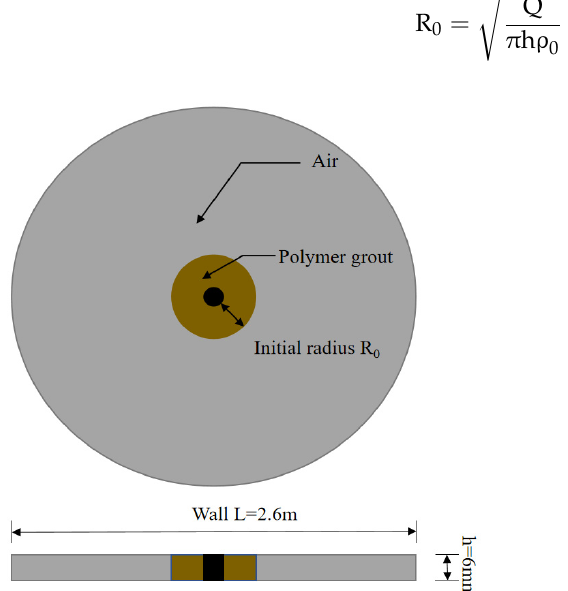
Figure 5. Schematic diagram of numerical model of polymer grouting in